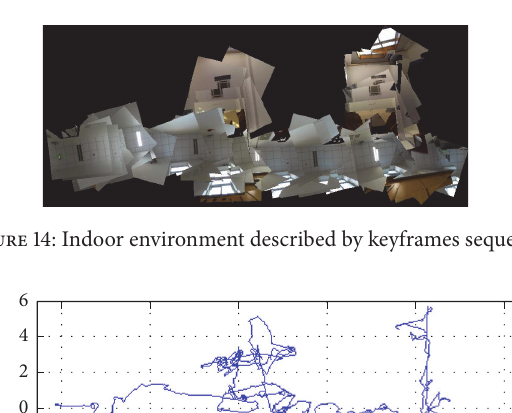
Figure 13: The global position relationship of keyframes sequence.